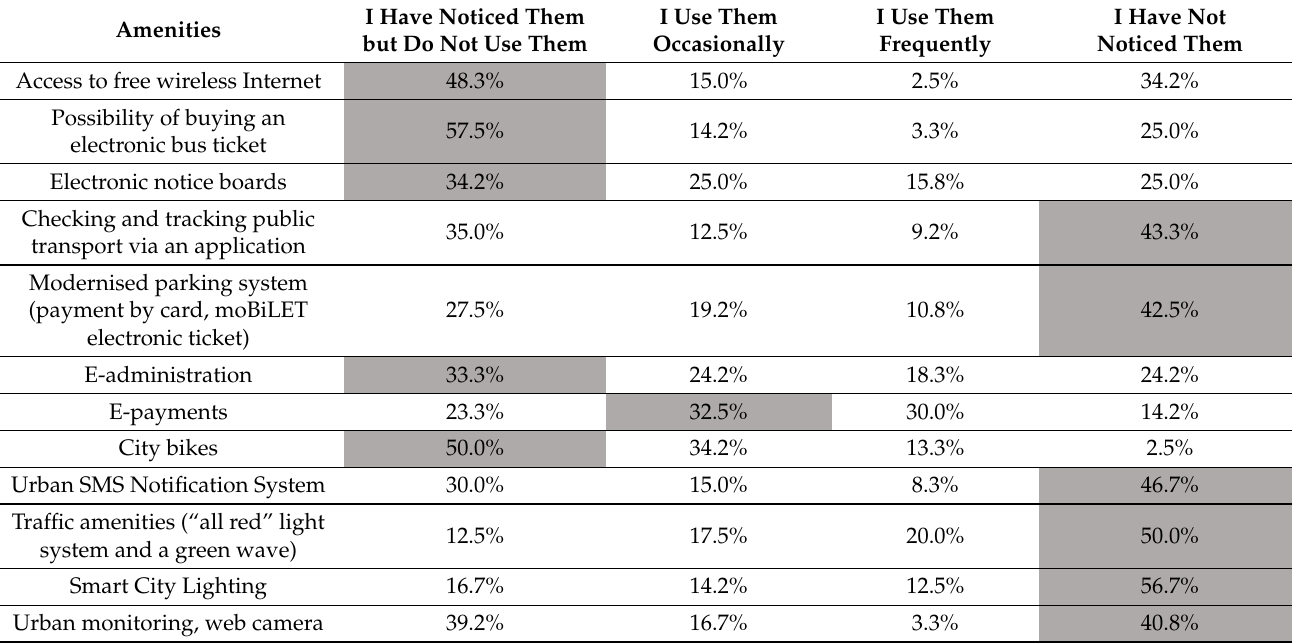
Table 5. Awareness of smart city solutions and the level of their use in the city of Suwałki.